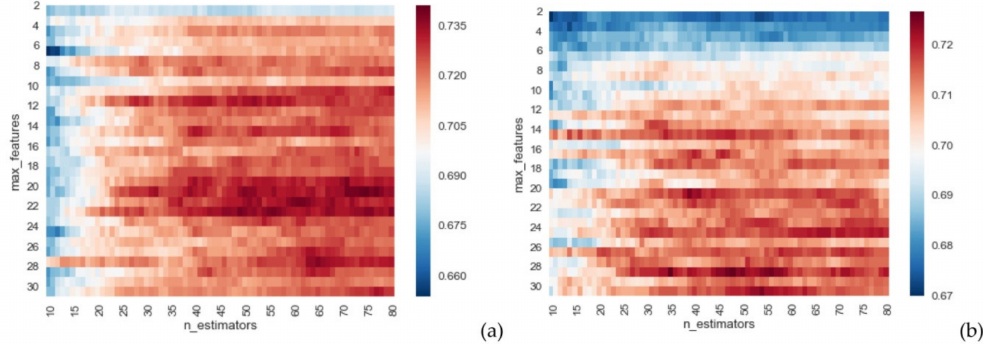
Figure 7. OOB_SCORE values under di ff erent parameter combinations. ( a ) S1: Street view feature participation; ( b ) S2: No street view feature